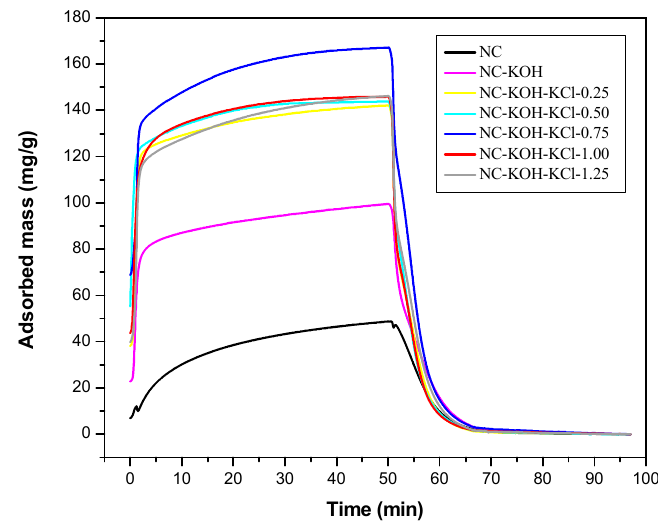
Figure 1. TG curves measured CO 2 adsorption and desorption of samples activated by different amount of KCl and 1.2 g KOH per 2.20 g resorcinol.